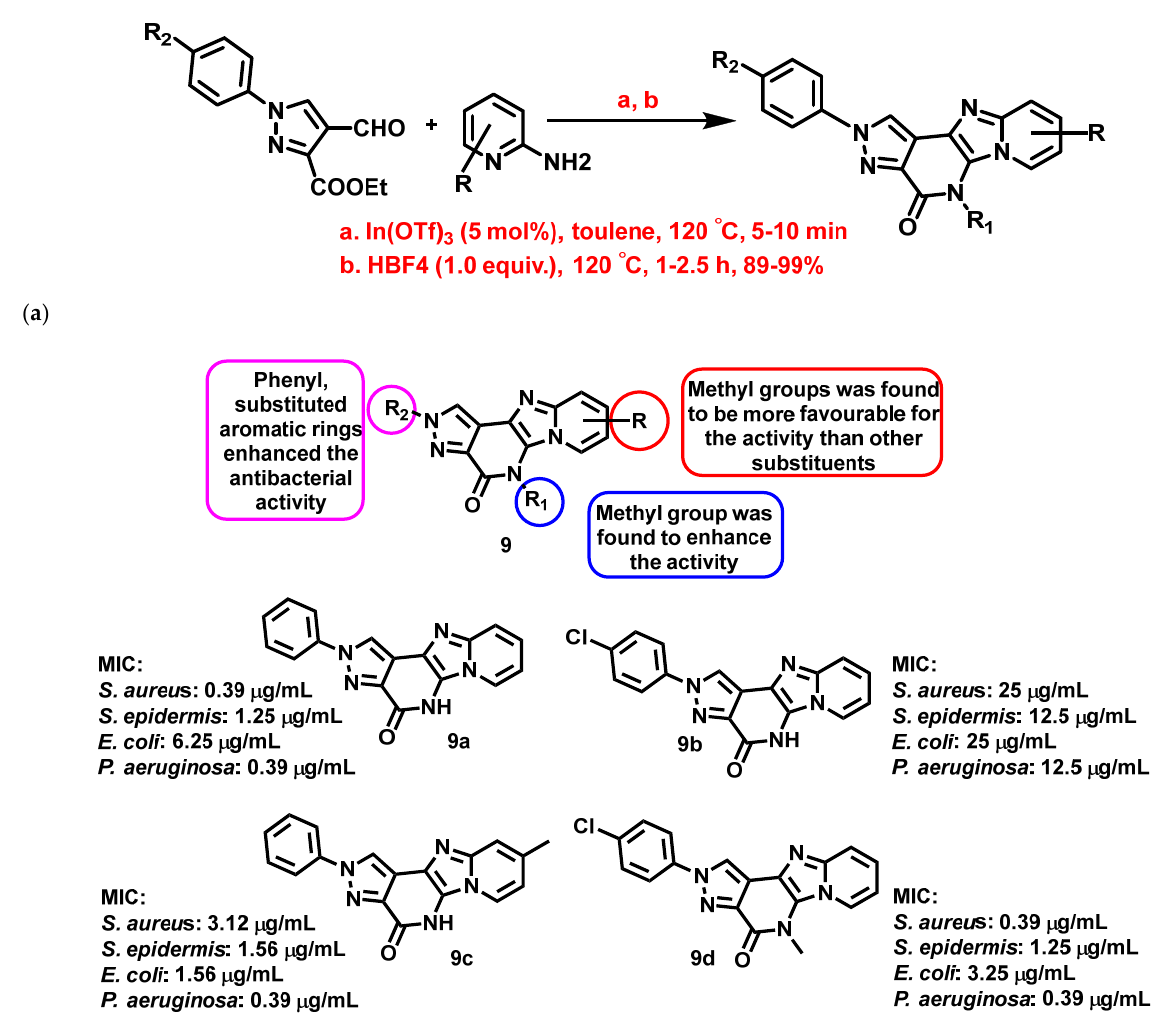
Figure 10. ( a ) Synthetic scheme of pyrazolopyridinone fused IZP derivatives. Signatures of compounds according to Devi et al., 2017 [64]. ( b ) A brief SAR of pyrazolopyridinone fused imidazopyridine derivatives. Signatures of compounds according to Devi et al., 2017 [64]. Further, Arora et al., 2014 [65], proposed that IZP ( 10 ) derivatives are potent antiMtb compounds that were shown to target respiratory bc1 complex in laboratory ‐ adapted strains of Mtb such as K14B0DS, H37Rv, cydKO. The results (Figure 11) highlighted the promiscuity of the bc1 complex in Mtb and the risk of targeting ATP or energy metabolism with novel therapeutics.